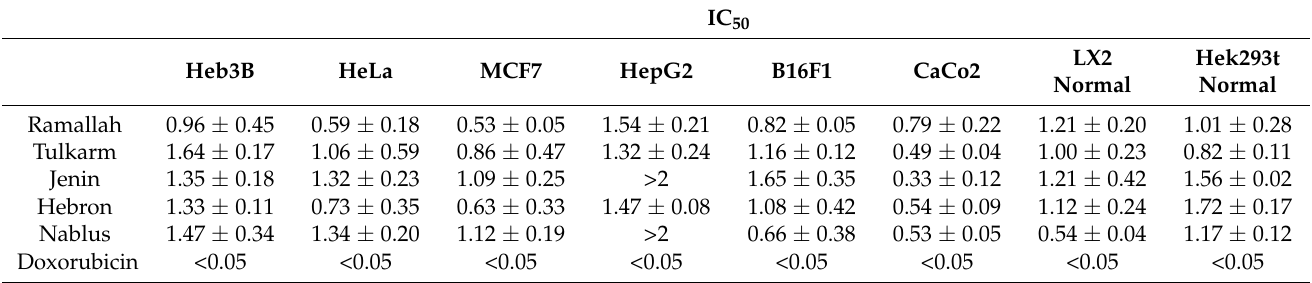
Figure 4. ( A – H ). Antiproliferative potential mediated by Rosmarinus officinalis essential oils derived from five Palestinian regions. Table 3. Antiproliferative activity IC 50 (mg/mL) of Rosmarinus officinalis essential oils collected from five different Palestinian regions and doxorubicin as positive control.